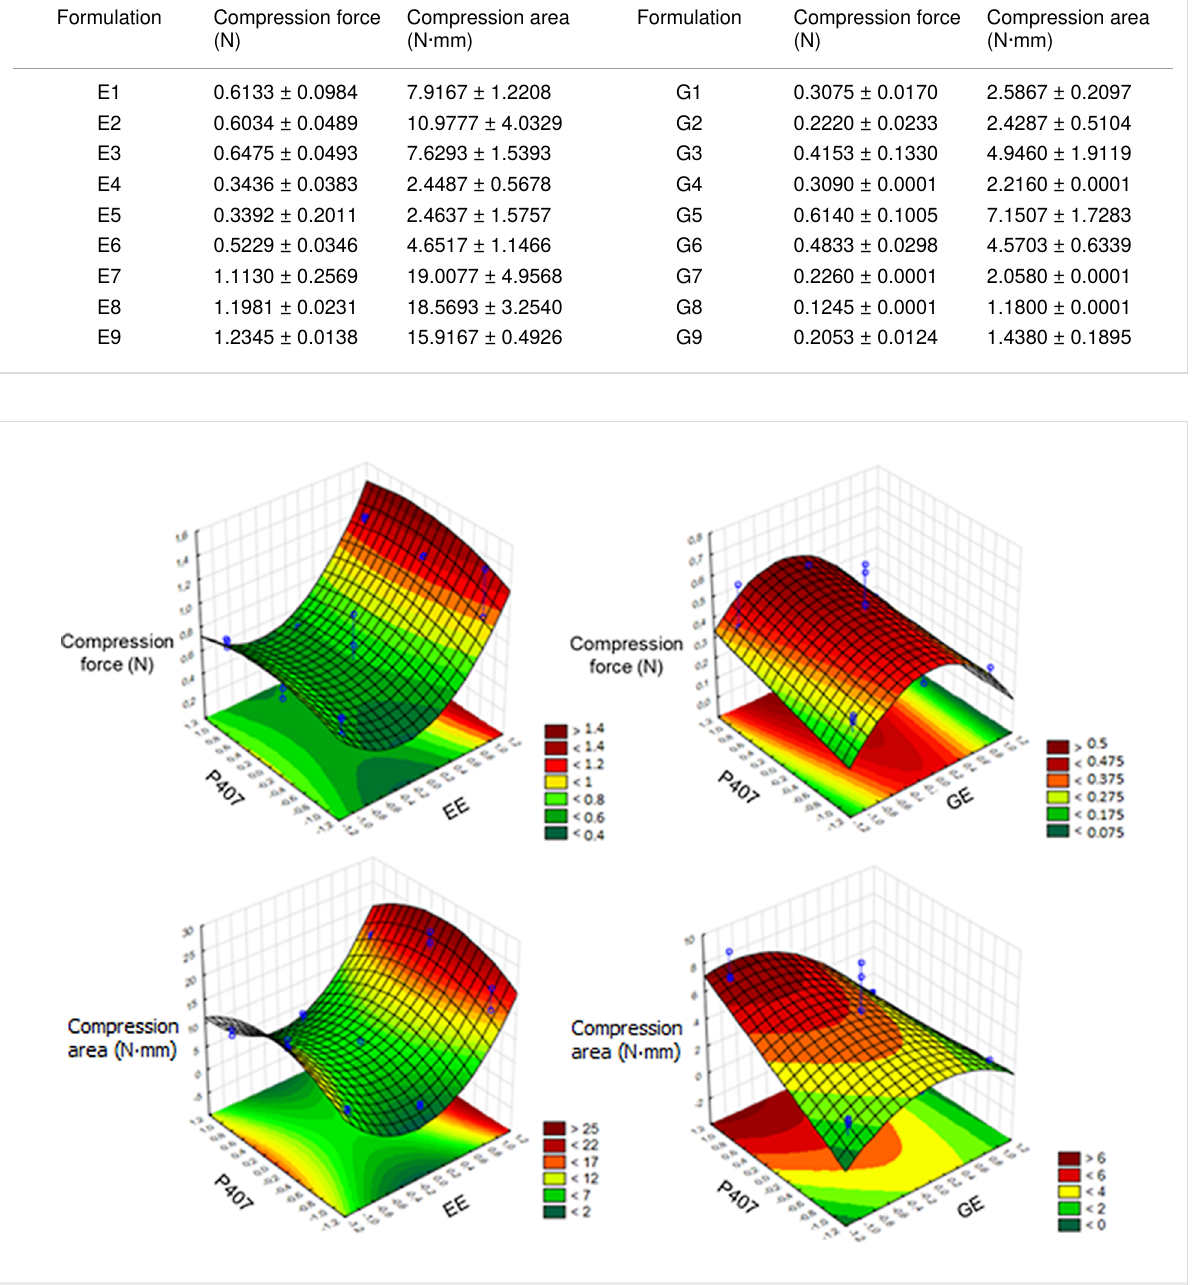
Figure 6: Response surface plots for force and compression area of MNs containing EE or GE. The color scale is indicated in each figure and shows the isoparametric values.